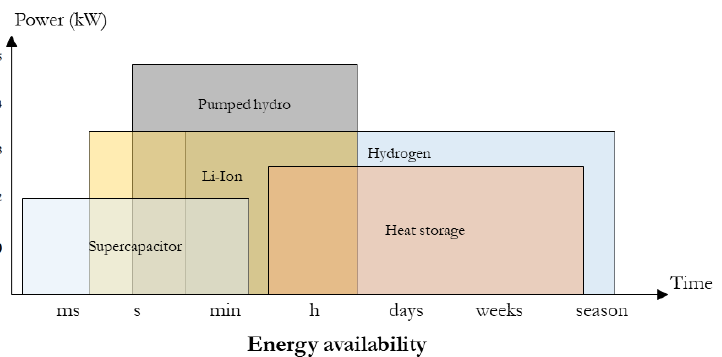
Figure 5. Comparison of the reported available power and energy, starting from the reaction time, of different energy storage systems